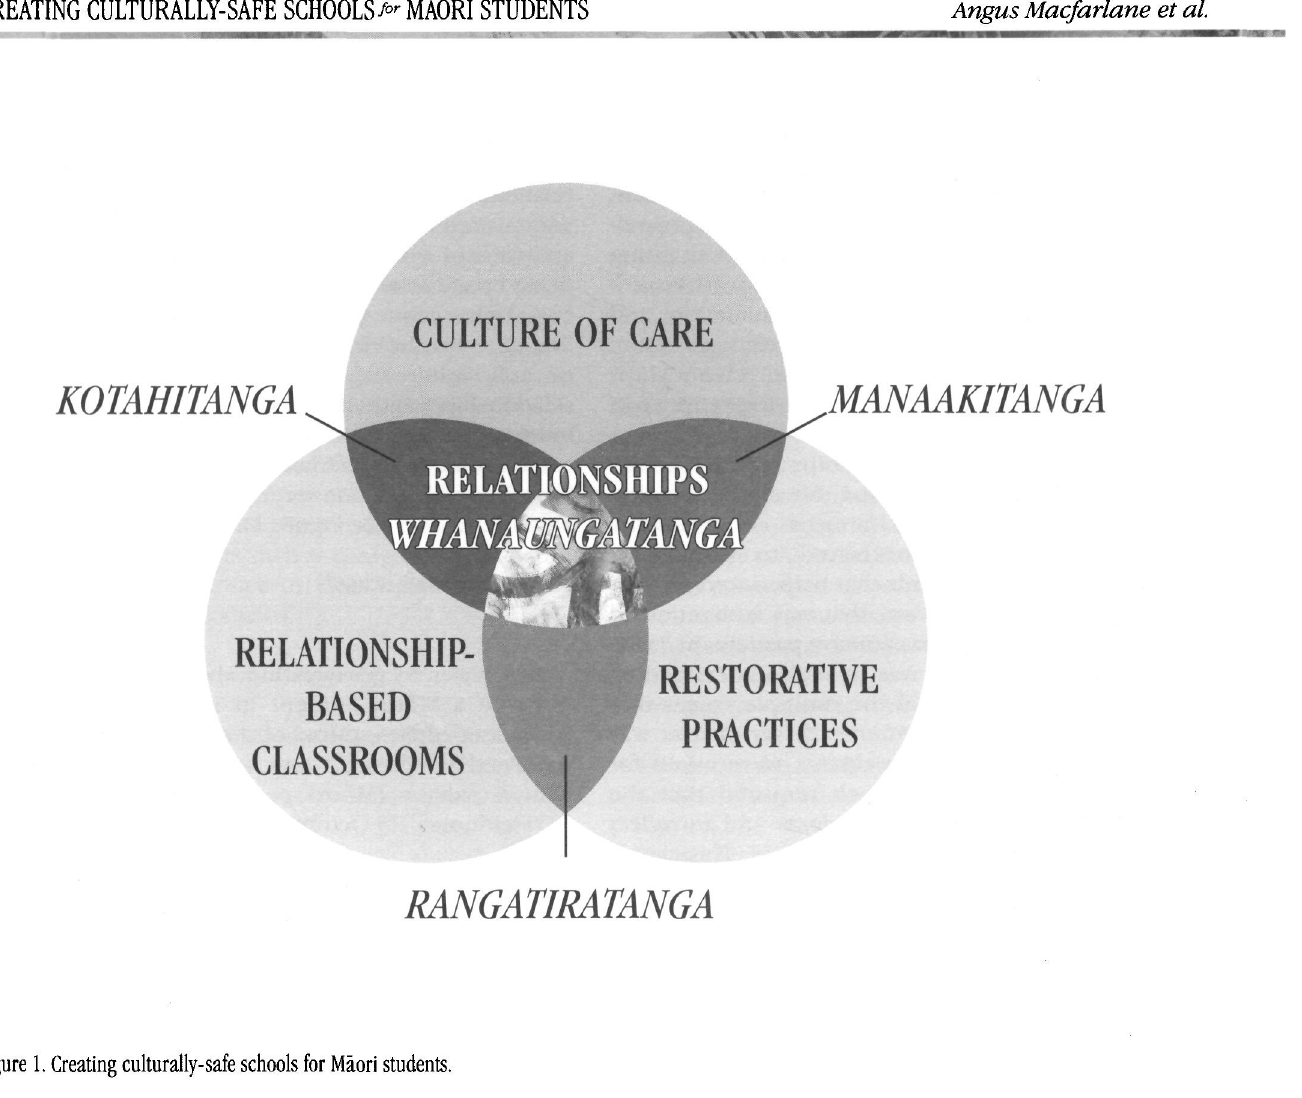
Figure 1. Creating culturally-safe schools for Maori